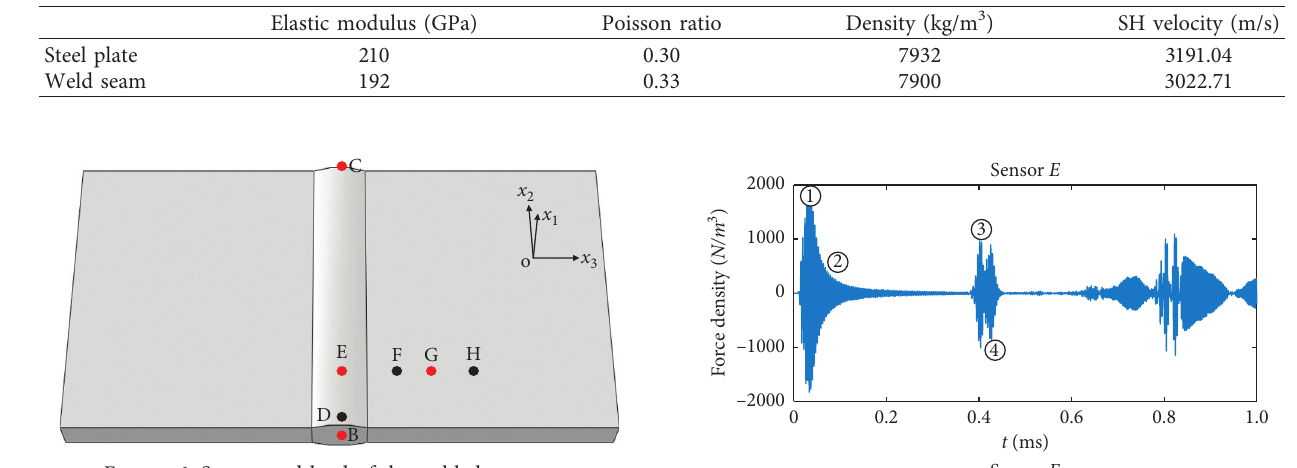
Table 2: Material parameters of the steel plate and weld seam.